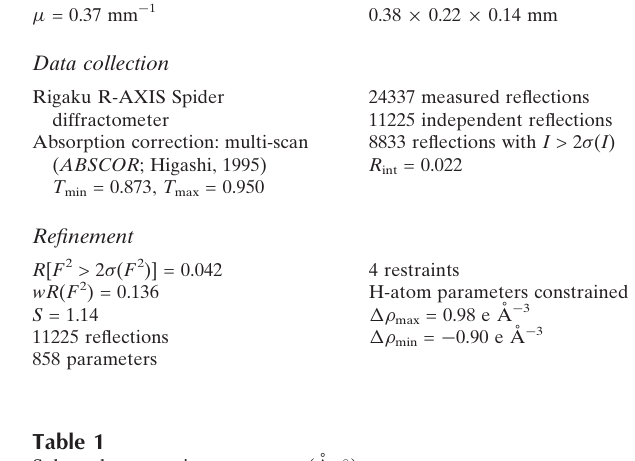
Selected geometric parameters (A˚ , (cid:3) ).